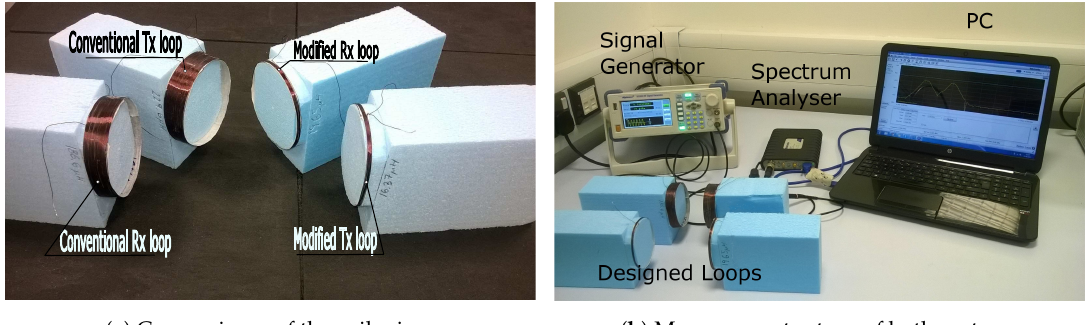
Figure 11. Practical implementation of the proposed model along with the required